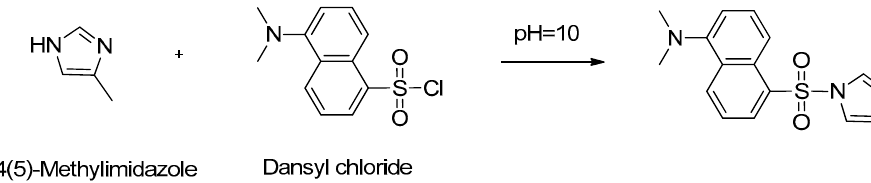
Figure 2. Derivatization reaction of 4(5)MEI with dansyl chloride.